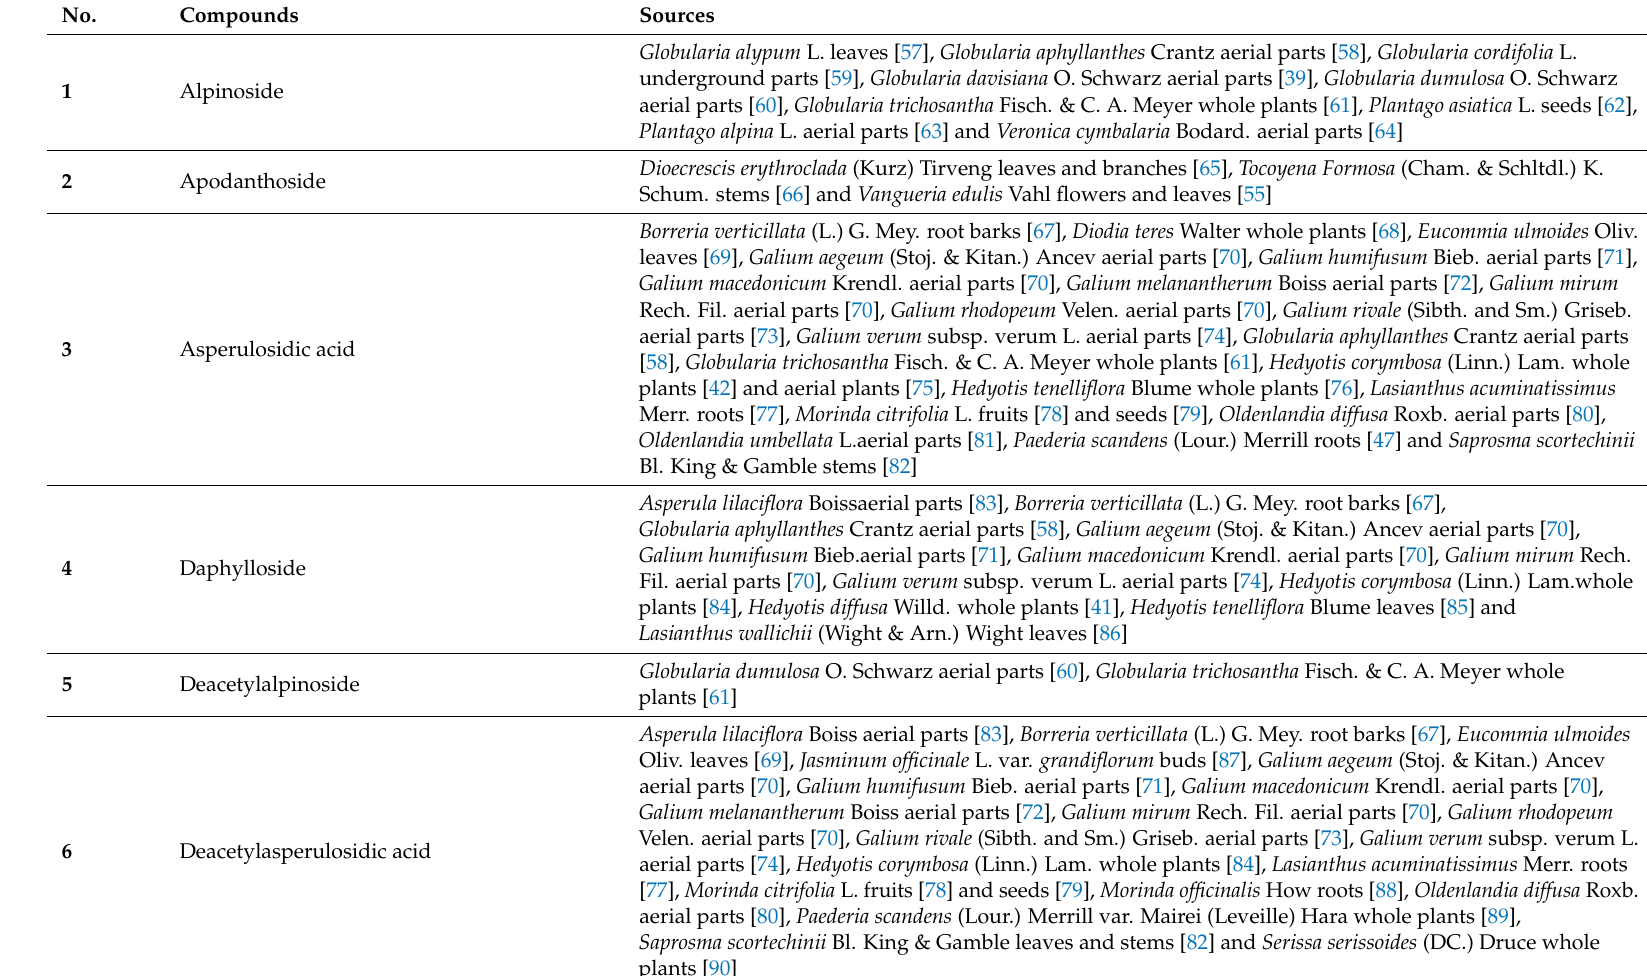
Table 2. Natural derivatives of